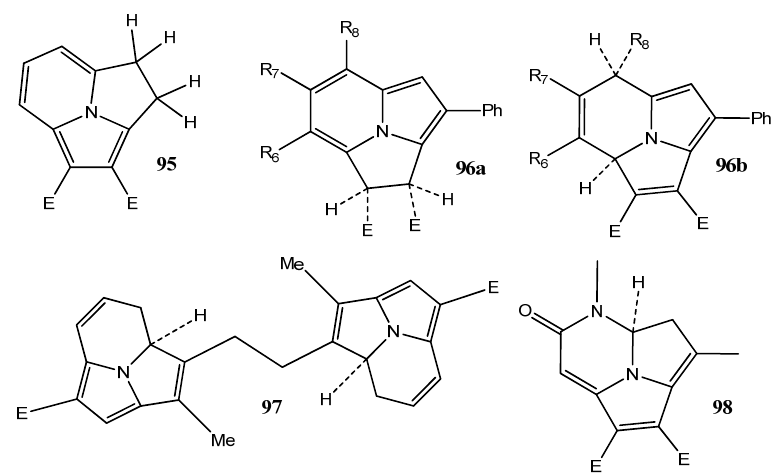
Scheme 53. Dihydrocyclazines obtained in the synthesis.